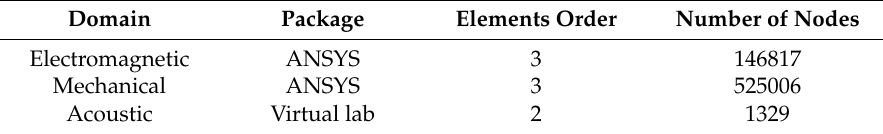
Table 3. Model detail. Table 2. Simulation detail by FEM and BEM.